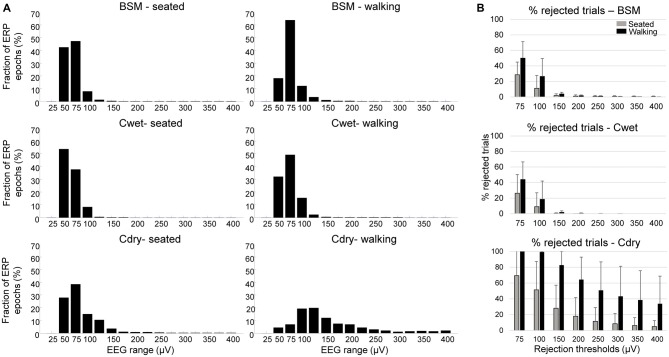
Fraction of event-related potential (ERP) epochs (%) distributed by signal peak-to-peak amplitude. In (A), mean distribution of epochs for Biosemi (BSM, top row), Cognionics wet (Cwet, middle row) and Cognionics dry (Cdry, bottom row) in steps of 25 μV (0–25, 26–50, 51–75, …, 376–400) in seated (left column) and walking conditions (central column). In (B), mean (SD) percentage of rejected ERP epochs for a variety of rejection thresholds in seated (gray bars) and walking condition (black
bars).